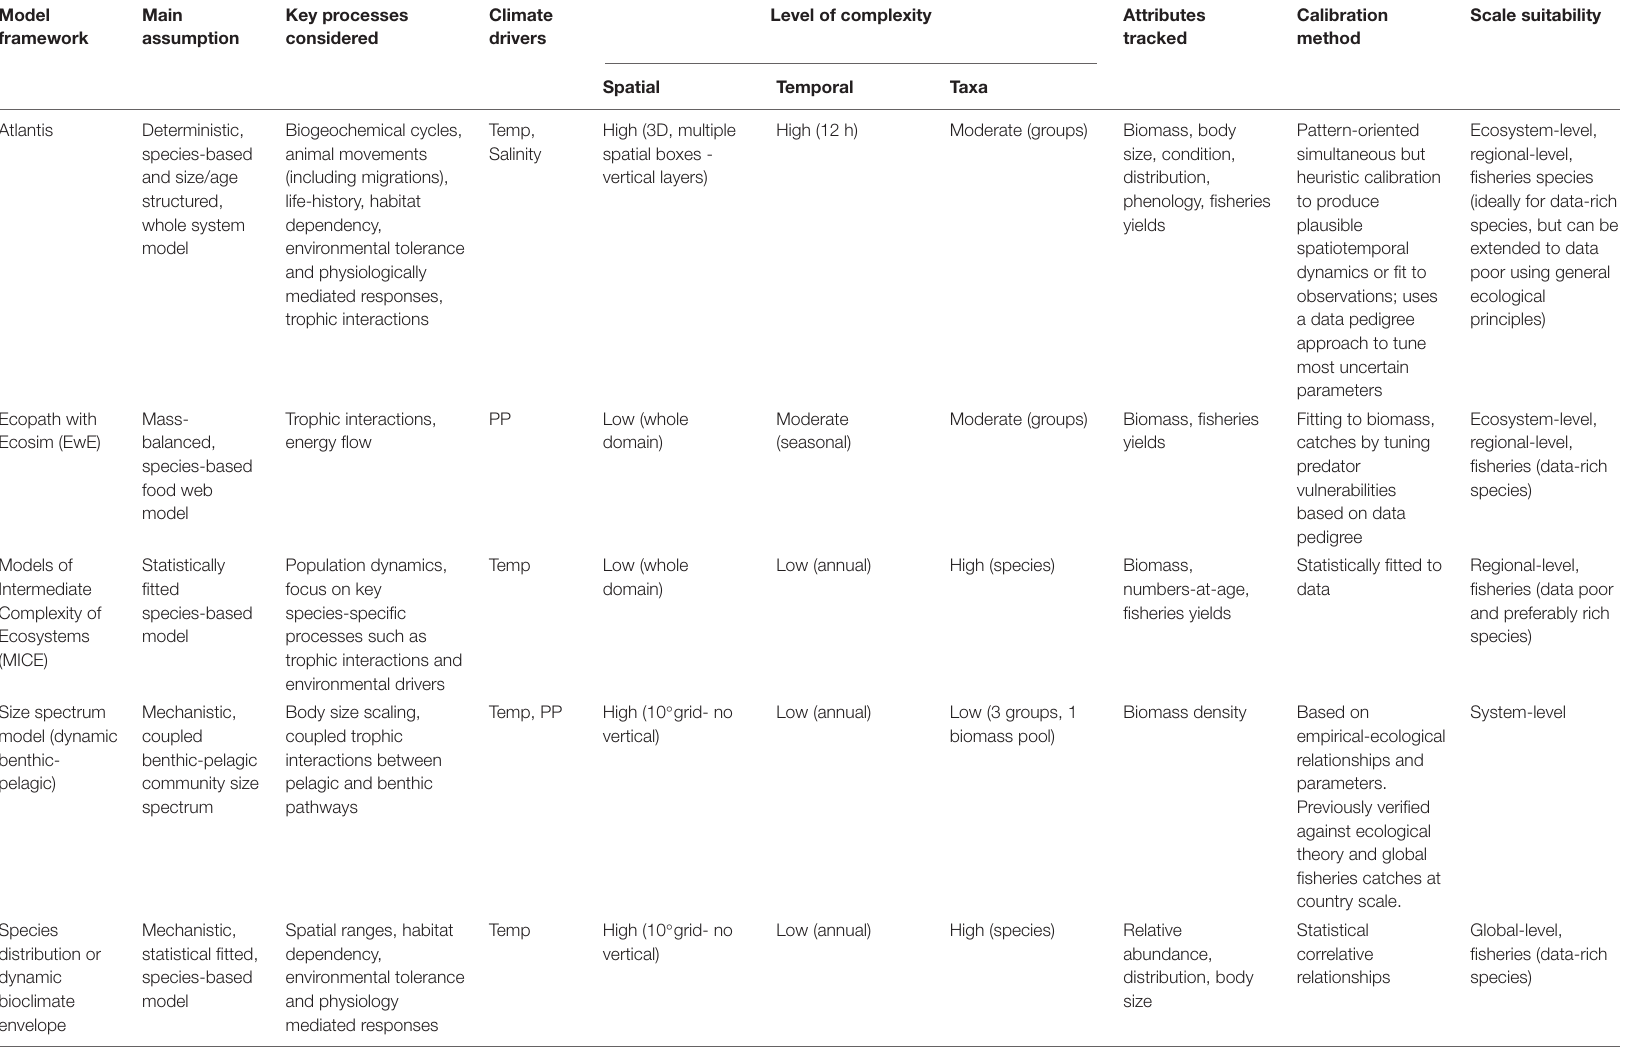
TABLE 1 | Summary of the main differences between the five model frameworks used to examine ecosystem responses to climate and fishing management drivers. Model